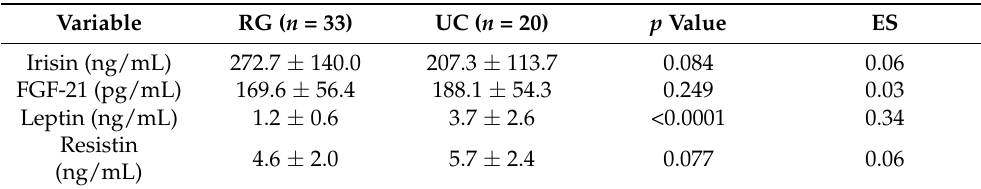
Table 2. Energy homeostasis regulating hormone concentrations (mean ± SD) in rhythmic gymnasts (RG) and untrained controls (UC).